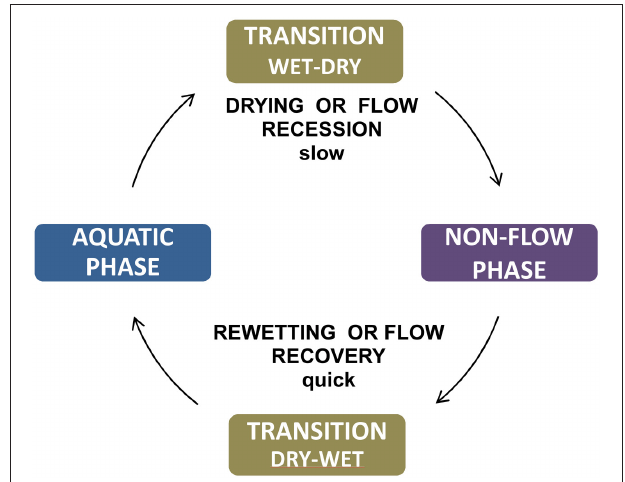
FIGURE 1 | The hydrological phases in temporary systems, with an indication of the speed associated to each